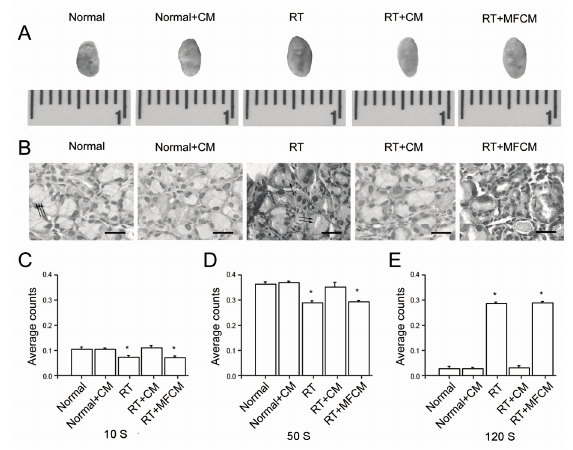
Figure 1. Radiotherapy-impaired lacrimal secretion and induced lacrimal gland injury in vivo . ( A ) Gross observation indicating normal and radiotherapy-treated lacrimal glands and the restorative effect of iPSC-CM or MFCM (mouse fibroblasts-derived conditioned medium) on irradiated lacrimal glands; ( B ) HE staining of irradiated lacrimal glands. Scale bar = 25 µm. One arrow means inflammatory cells, two arrows means the apoptotic acinar cells and three arrows means normal acinar cells; ( C – E ) Scintigraphic assessment of lacrimal gland secretion function of normal, normal + CM, RT, RT + CM, or RT + MFCM (CM: iPSC-CM, RT: radiotherapy, MFCM: mouse fibroblasts conditioned medium); N = 5. The values are the means ± SD. * p <